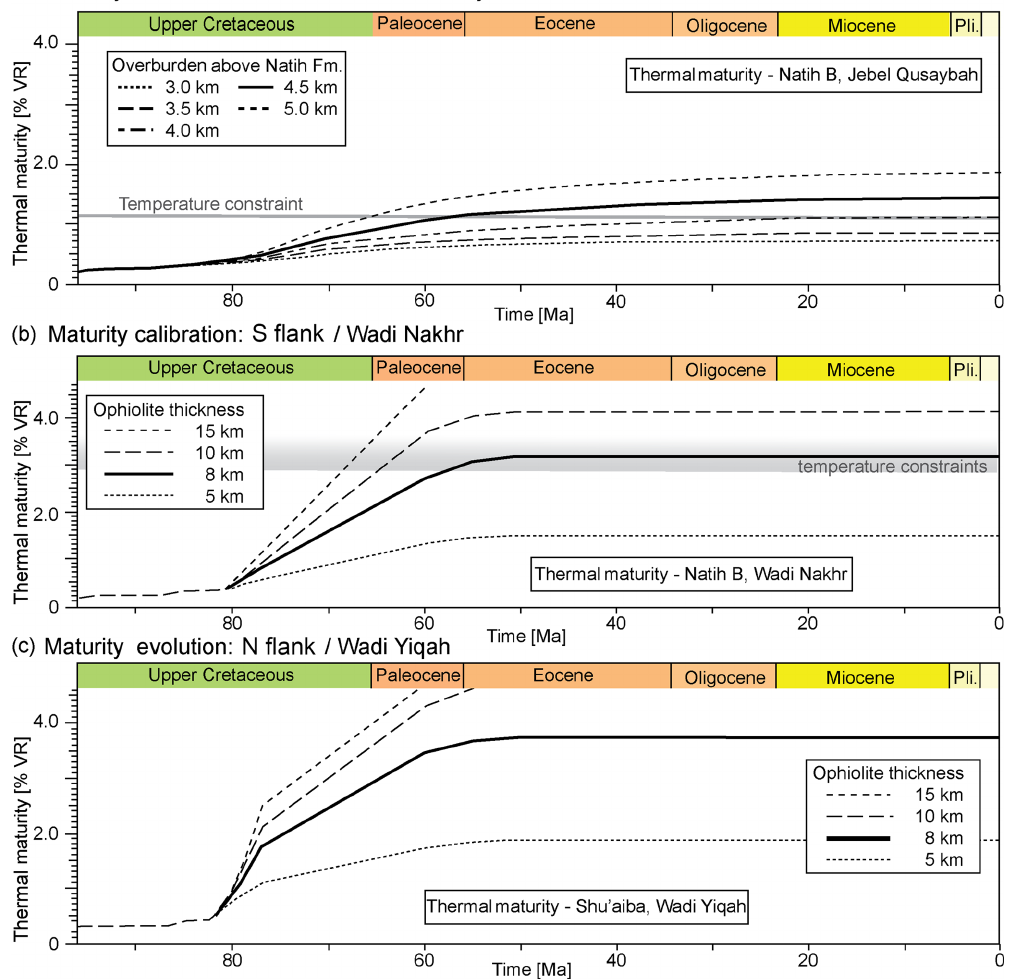
Figure 10. Sensitivity analysis of paleo-overburden and its influences on thermal maturity in comparison to calibration data (gray area). Data are used to calibrate burial depth of the foredeep at the Jebel Qusaybah (a) and the paleo-ophiolite thickness at the southern flank of the mountains at Nakhr (b) . Its northern counterpart at Yiqah (c) is in agreement with the temperature data in Fig. 9, but too mature to be reconstructed by standard maturity modeling (Sweeney and Burnham,